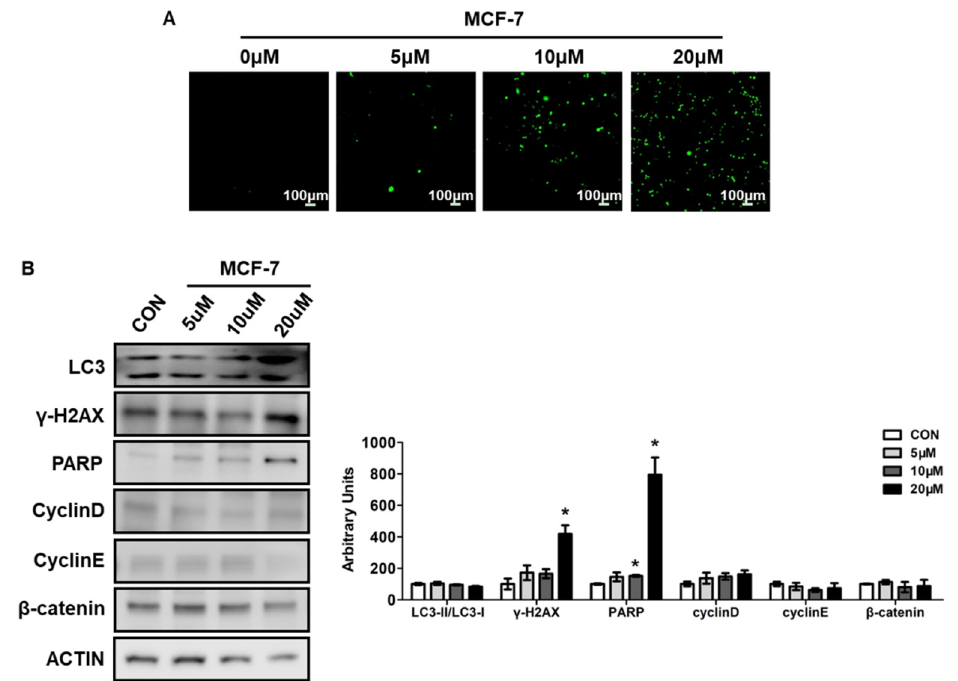
Figure 5. Compound 5d increased ROS levels and induced DNA damage. ( A ) MCF-7 cells were treated with 5 μ M, 10 μ M, 20 μ M of compound 5d for 24 h, then cells were stained by DCFH-DA for 30 min, ROS were detected using fluorescent confocal microscope. ( B ) MCF-7 cells were treated with 5 μ M, 10 μ M, 20 μ M of compound 5d for 48 h, cell protein were collected and analyzed by Western boltting. Left: western bolt of LC3, γ -H2AX, PARP, Cyclin D, Cyclin E, β -catenin; right: quantitative measurements relative to ACTIN. Data were presented as means ± SEM, * p < 0.05.